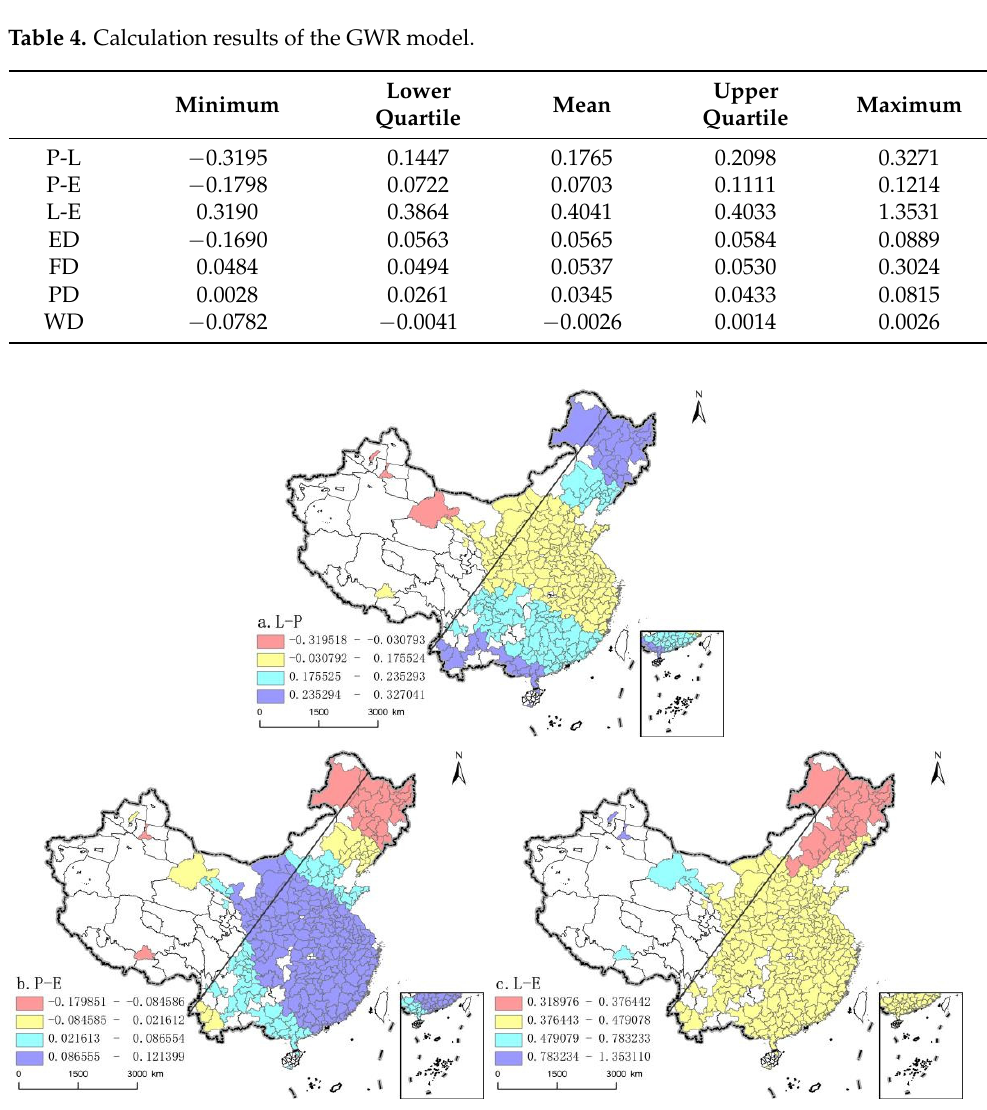
Figure 4. The spatial coefficient distribution of internal driving force ( a ) production-living function, ( b )production-ecological function, ( c ) living-ecological function.